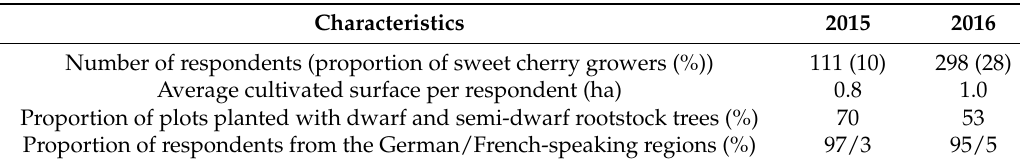
Table 2. Summary statistics of selected characteristics of responding growers and their sweet cherry crops in two consecutive years.